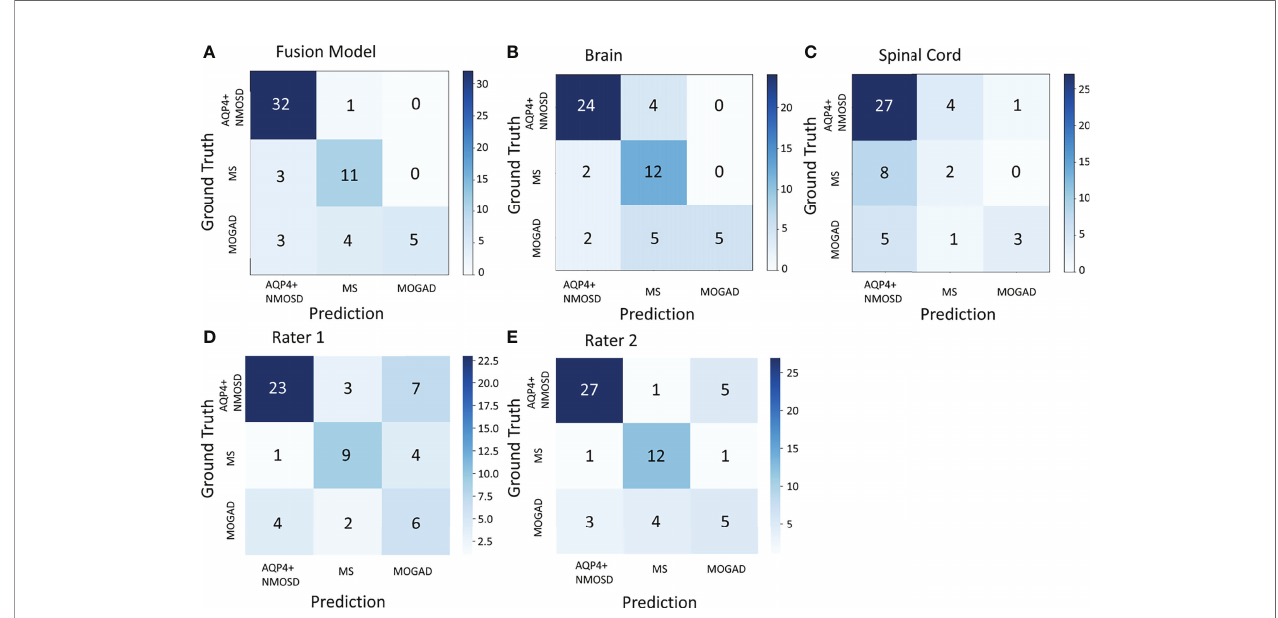
FIGURE 3 | The confusion matrix of the fusion model in the test dataset of 59 patients (A) , the model based on the brain MRI (B) , the model based on the spinal cord MRI (C) , and human rater 1 and 2 (D, E) . AQP4+ NMOSD, aquaporin 4 positive neuromyelitis optica spectrum disorders; MOGAD, myelin oligodendrocyte glycoprotein antibody associated disease; MS, multiple sclerosis.